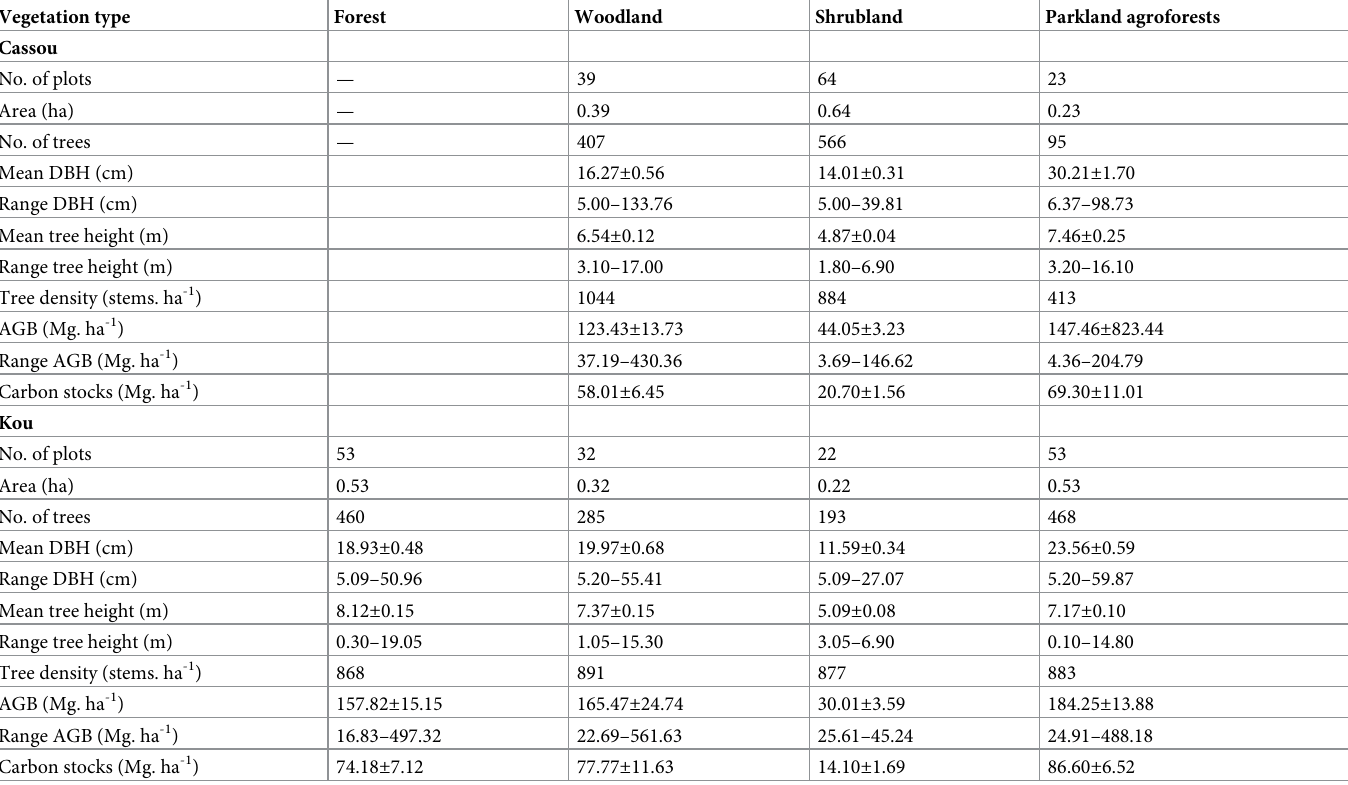
Table 2. Descriptive statistic of structure and composition of trees in different vegetation types in Cassou and